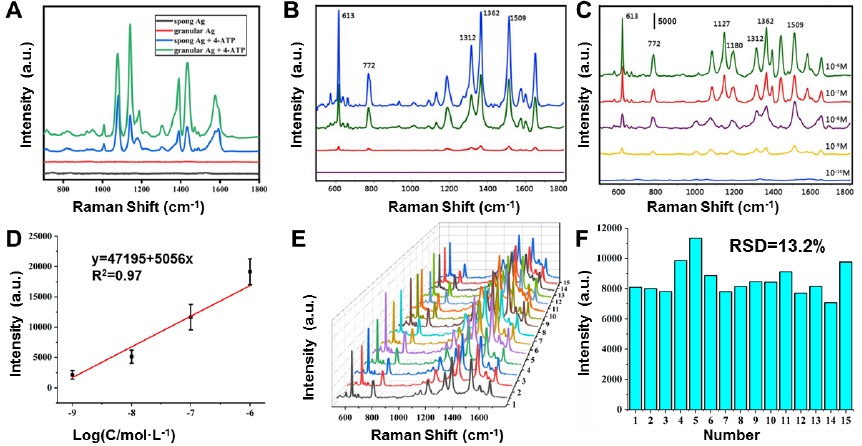
Figure 4. ( A ) Sponge and granular porous Ag used as a SERS substrate to detect 10 − 6 M 4-ATP. ( B ) Particles prepared at different ratios of NaBH 4 to AgCl (purple curve 0, red curve 1:2, green curve 1:1, blue curve 2:1) were used to detect 10 − 6 M R6G. ( C ) Granular porous Ag used as a SERS substrate to detect R6G at 10 −6 M – 10 −10 M. ( D ) Intensity of 613 cm −1 as a function of the concentrations of R6G. ( E ) SERS spectra of 15 different points of R6G. ( F ) Graphs of the intensity of the peaks at 613 cm − 1 from 15 SERS spectra.